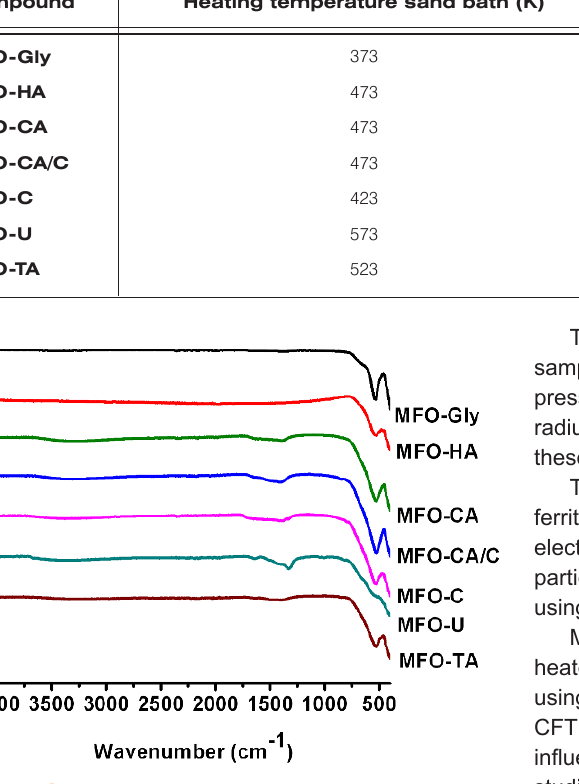
Figure 2. IR spectra of magnesium ferrite powder heat treated at